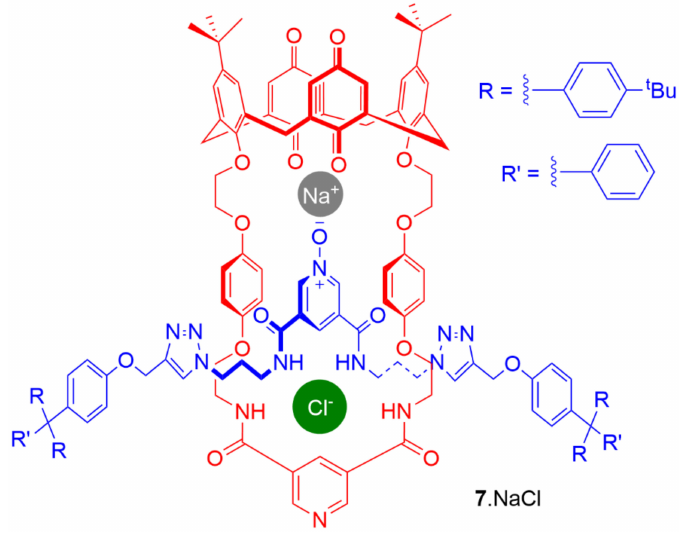
Figure 7. Knighton and Beer’s rotaxane 7 exhibiting axle separated cooperative ion pair binding.